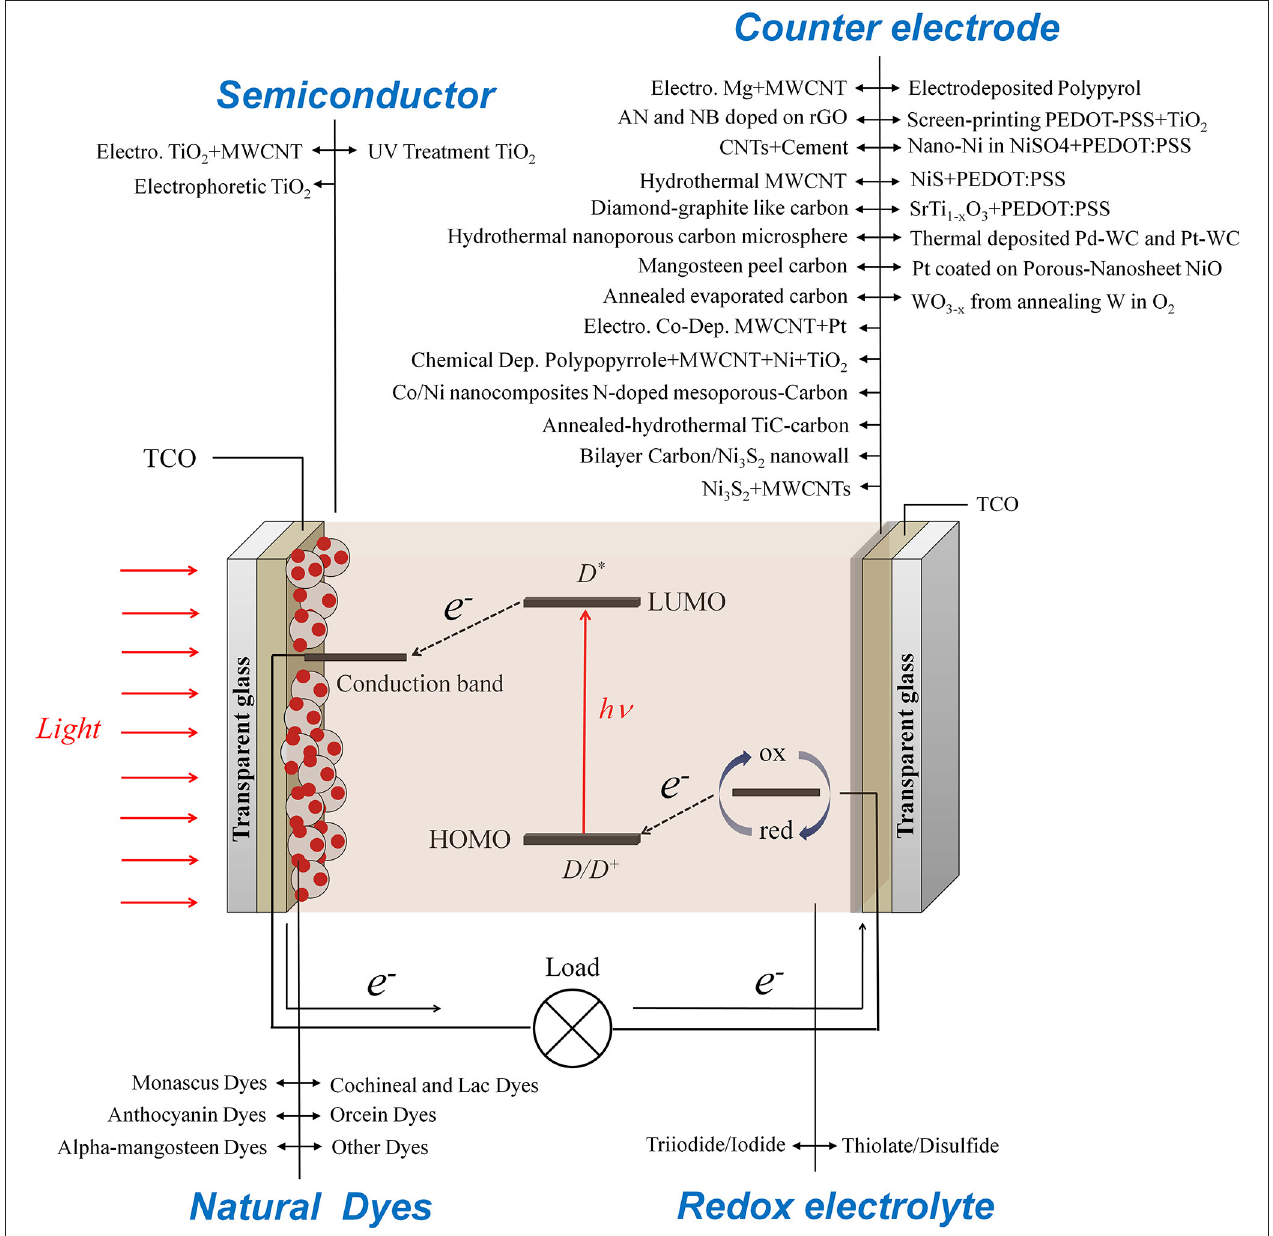
FIGURE 1 | Schematic diagram of DSSC structure and its functional